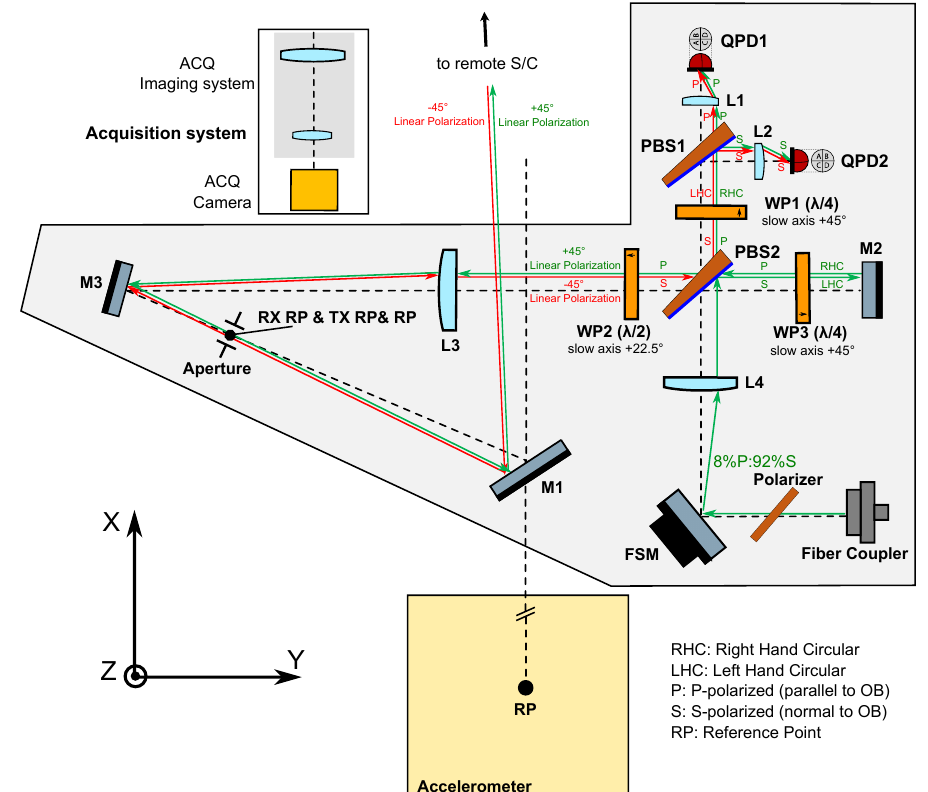
Figure 2. Optical bench layout. The green arrows depict the path and direction of the local oscillator and transmit beams, which originate from a single beam injected into the bench via a fiber injector. The red arrows depict the path and direction of the receive beam, which couples into the bench via mirror M1. The polarization state of each beam is indicated (RHC—right hand circular; LHC—left hand circular). The receive and transmit reference points (RX/TX RP) coincide in the left focal plane of lens L3, along the optical axis between mirrors M3 and M1. The RX/TX RP is imaged into the spacecraft center of mass, where an accelerometer is located. The range measurement is invariant under rotations of the spacecraft around this point. The receive and local oscillator beams interfere at polarizing beamsplitter PBS1, and are captured by the pair of quadrant photodiodes QPD1 and QPD2 in balanced detection